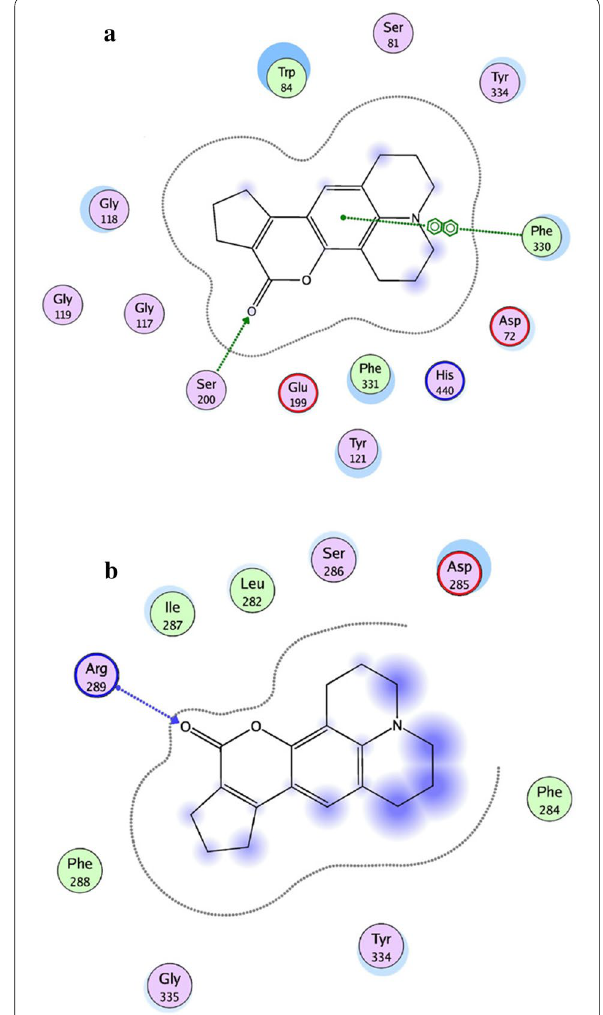
Fig. 5 a Propose binding of C1 at the active gorge site. b Propose binding of C1 at the peripheral anionic site